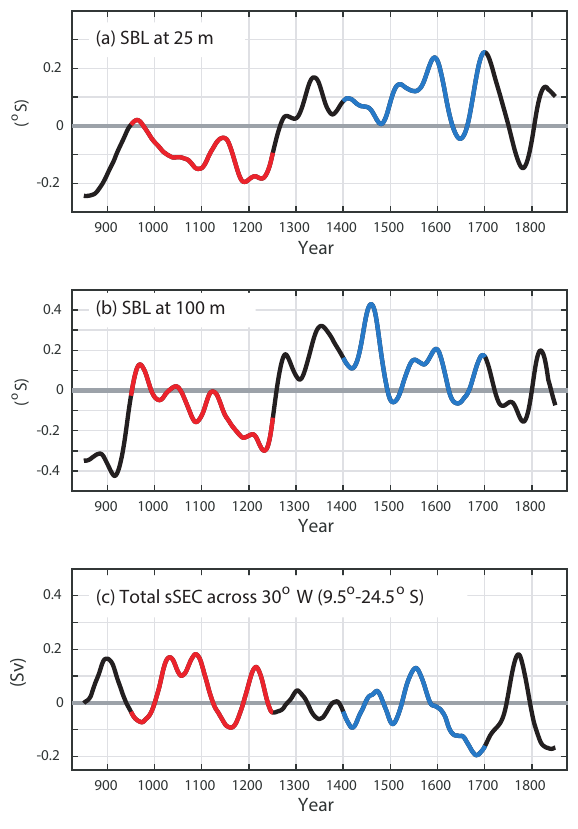
Figure 4. SBL and total sSEC time series. Low-passed (30-year), standardized anomalies of the SBL at 25 m ( a ) and at 100 m ( b ) and of the total westward sSEC transport across 30 ◦ W, between 9.5 ◦ S and 24.5 ◦ S and above 200 m ( c ). The MCA period is marked in red, while the LIA is marked in